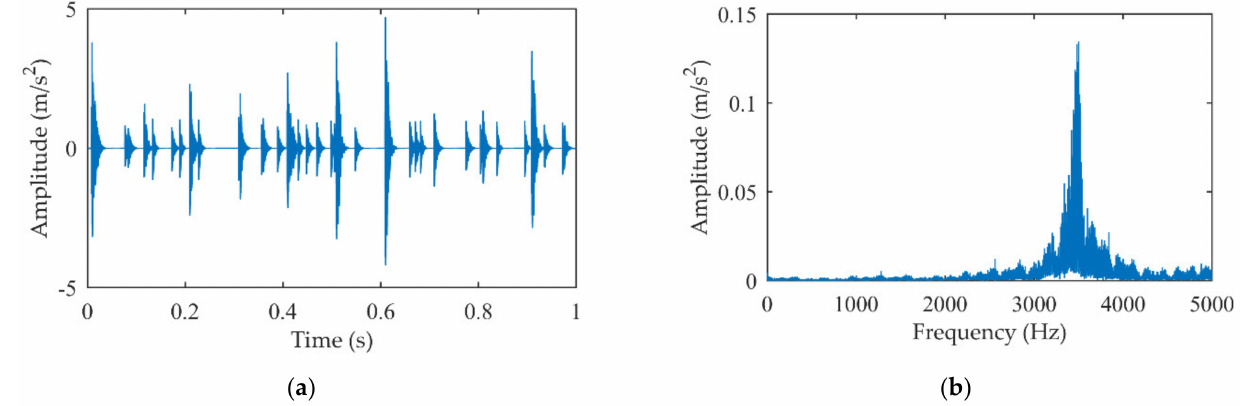
Figure 6. The extracted impact signal by EMD + MP: ( a ) Time domain signal; ( b ) Amplitude